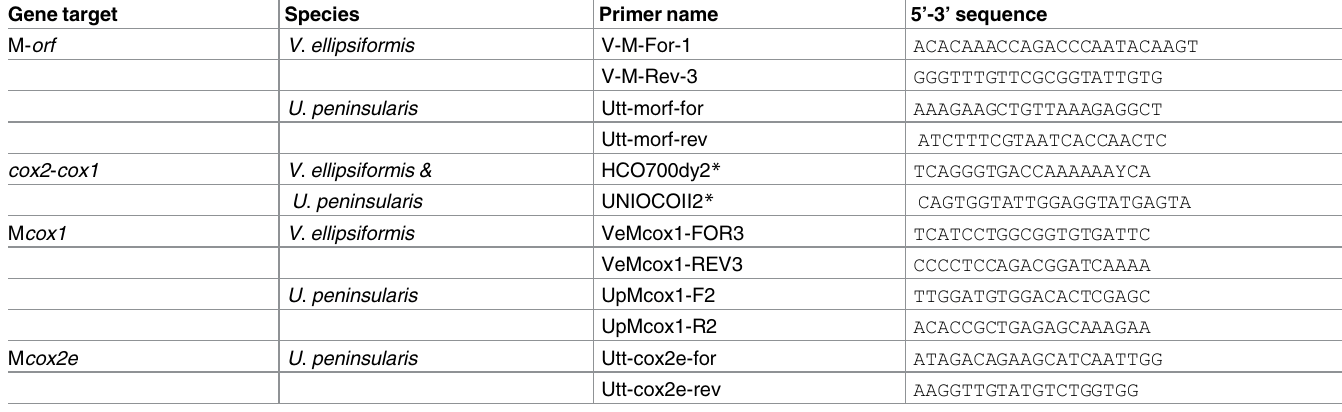
Table 1. Details of primers used in this study for the amplification of M-specific segments. Gene